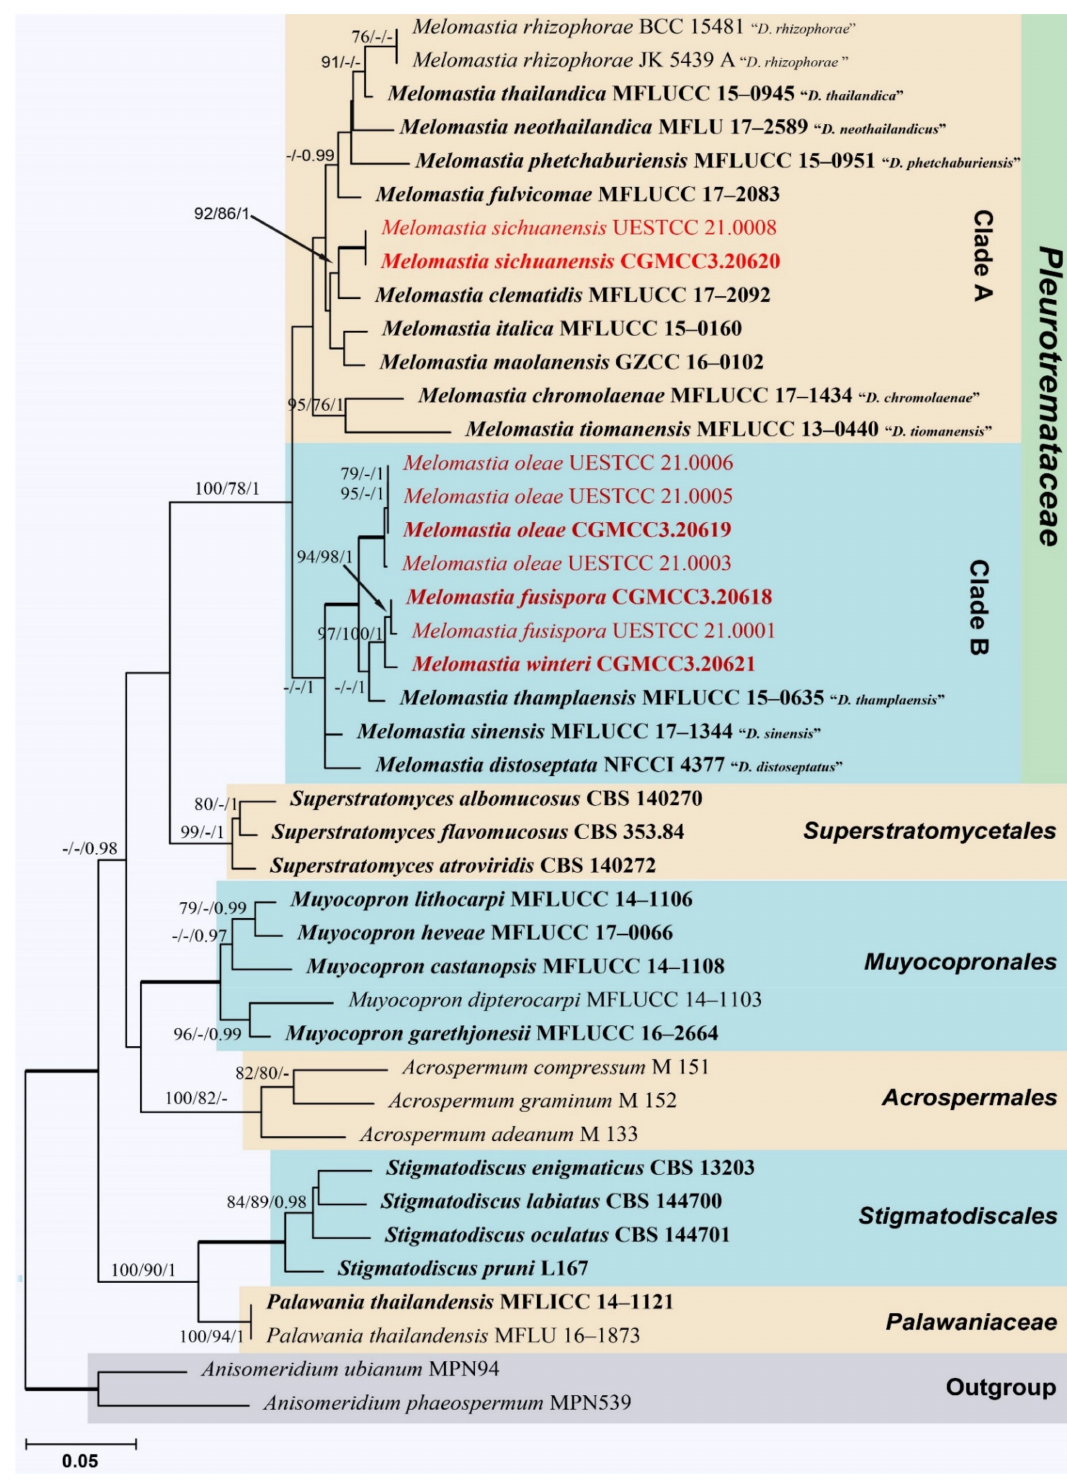
Figure 1. Phylogram generated from maximum likelihood (ML) based on an LSU–SSU– tef1- α se- quence matrix. The tree is rooted with Anisomeridium phaeospermum (MPN539) and A. ubianum (MPN94). The ML, MP bootstrap supports ( ≥ 75%) and BI posterior probabilities ( ≥ 0.95 PP) supports are given near the nodes, respectively. Branches with 100% ML BS, 100% MP BS and 1.00 PP are thickened. Ex-type strains are in bold, and the newly introduced taxa are in